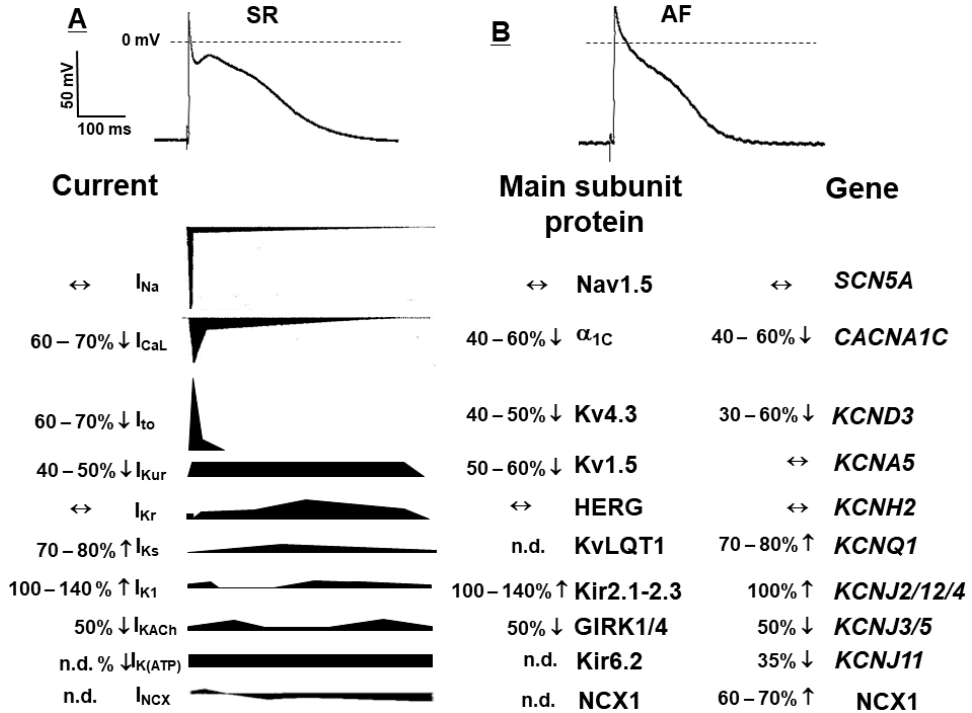
Figure 2. The most important transmembrane ionic inward and outward currents determining atrial action potential in sinus rhythm (SR, A ) and in permanent atrial fibrillation (AF, B ). The ion channel/current (functional elements) density changes are presented in bottom left column, while the expression level current subunit forming proteins and mRNA genes, respectively, are depicted in middle and right columns. The corresponding pictograms near each ion current name present the magnitude and time course of the current reflection of relative real sizes. ↓ —decreased current or downregulated protein/gene, respectively; ↑ —increased current or upregulated protein/gene, respectively; ↔ —unchanged current, protein or gene, respectively; n.d.—no